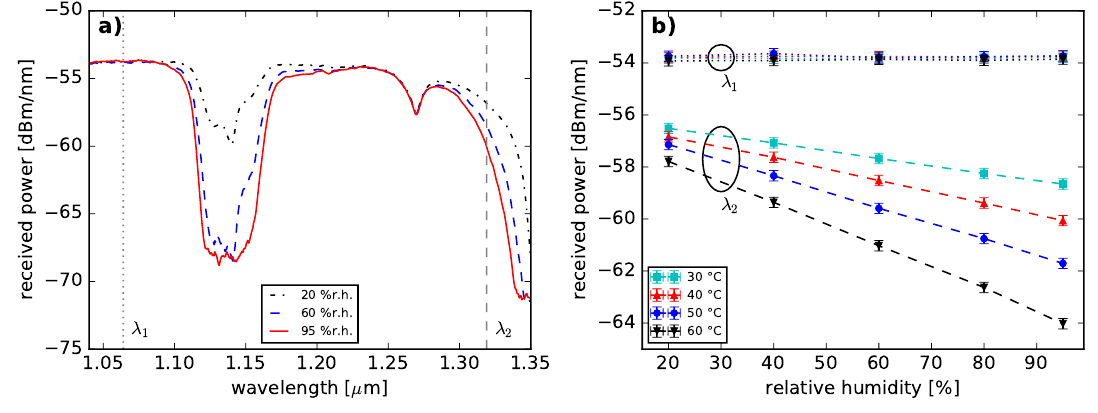
Figure 1. ( a ) Transmitted optical power spectra of a 200 m PFGI-POF under variation of relative humidity at 40 ◦ C. ( b ) Transmission power as a function of humidity at specified temperatures and two wavelengths ( λ 1 = 1064 nm and λ 2 = 1319